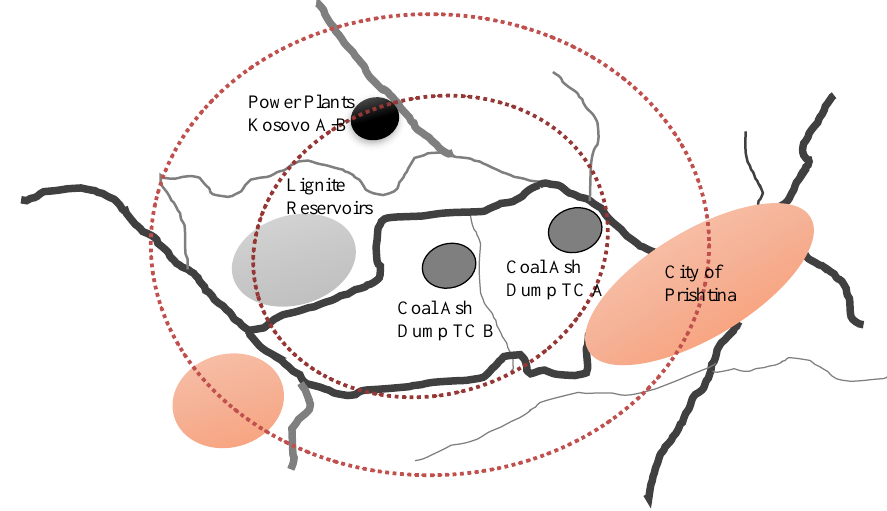
Fig. 1. Spatial relation of Prishtina, Power plants TC A-B, lignite reservoirs, and coal ash